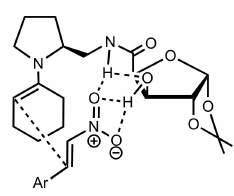
Figure 26. The proposed transition state for the Michael additions catalysed by 359